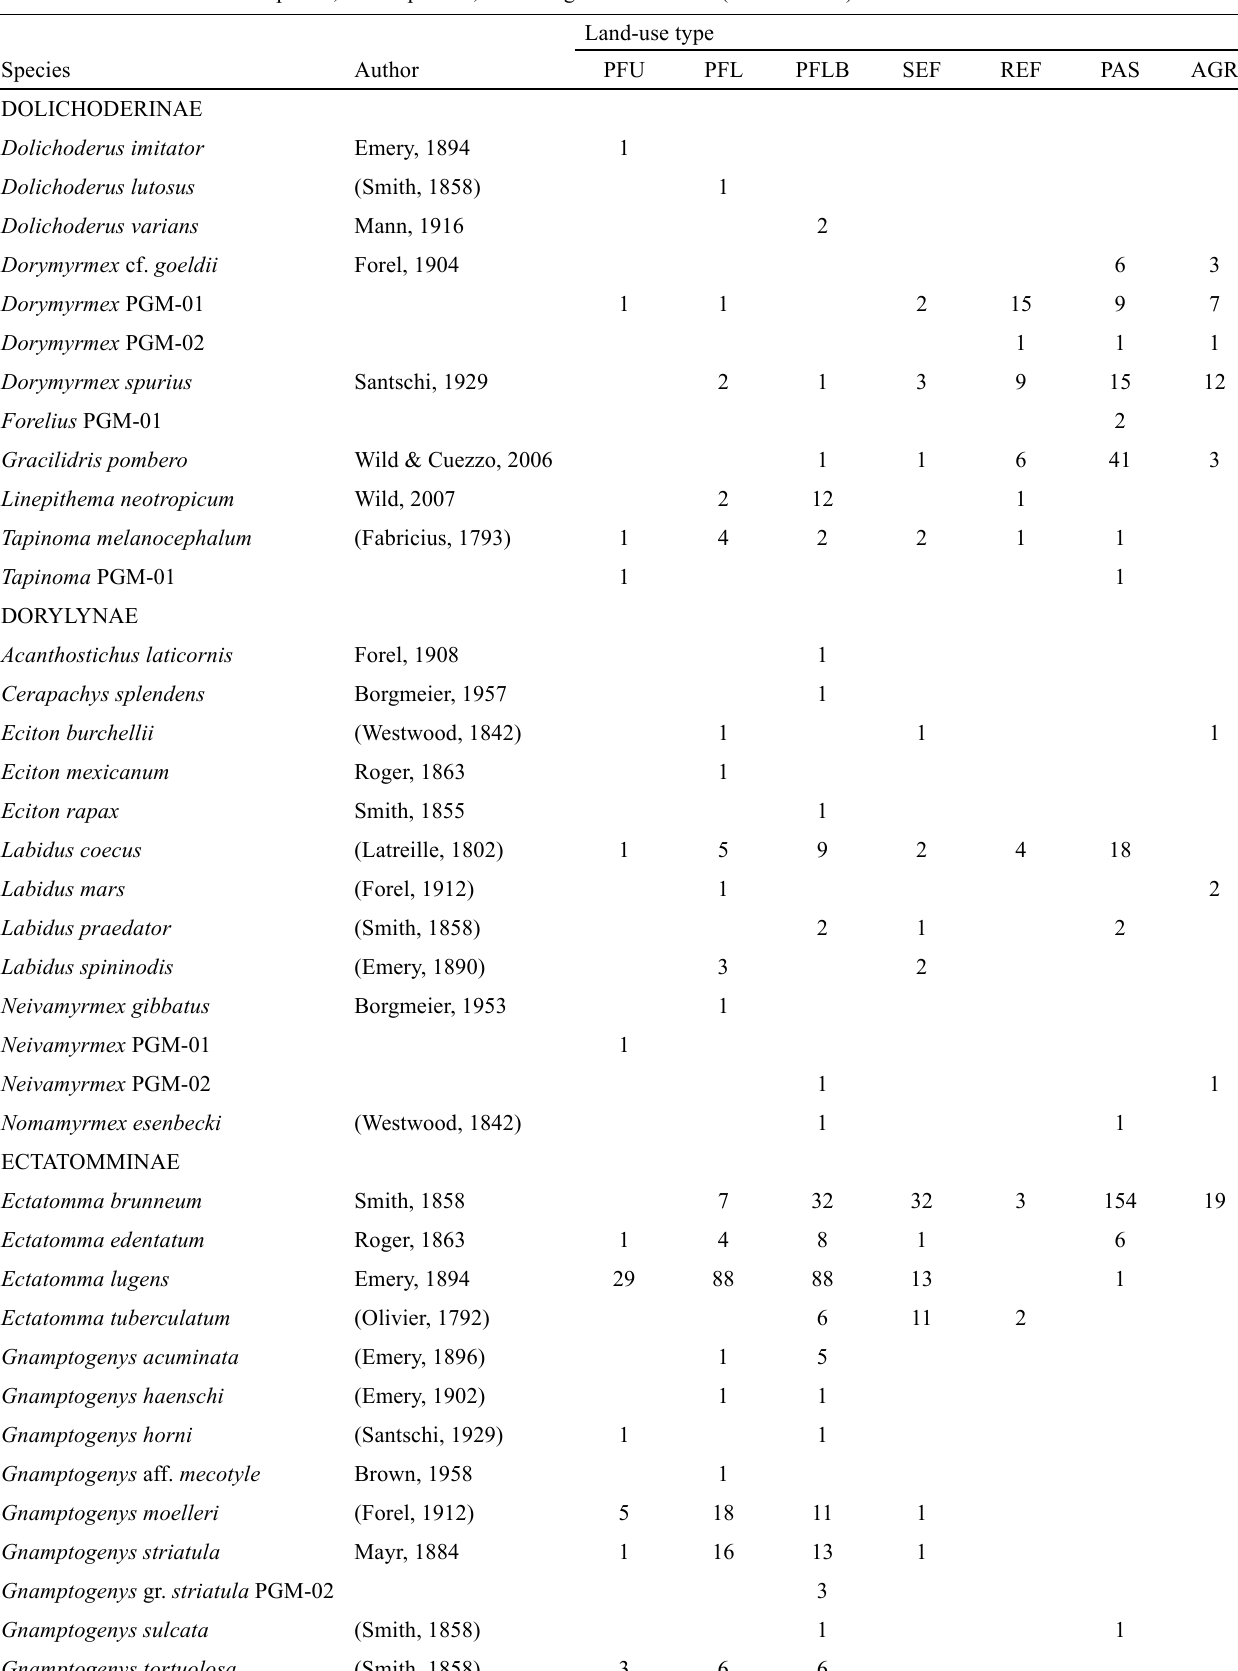
Table 2 . List of ant species collected in this study. Values represent number of records per pitfall traps of each species in each land-use type: PFU – primary forest undisturbed, PFL – primary forest logged, PFLB – primary forest logged and burnt, SEF – secondary forest, REF – reforestation with commercial species, PAS – pasture, AGR – agricultural areas.